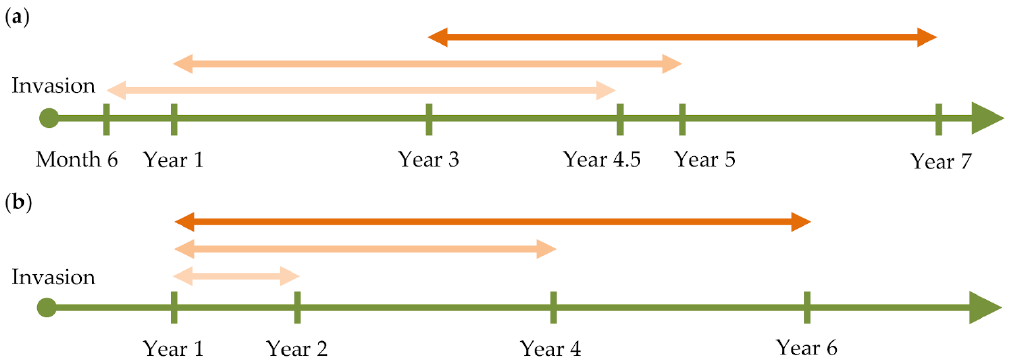
Figure 3. Diagrammatic representation of the two sets of simulations demonstrating use of the model. ( a ) Grass carp were stocked (1) six months, (2) one year, or (3) three years after invasion to determine the number that would be needed to eradicate Hydrilla within four years of stocking. ( b ) Grass carp were stocked one year after invasion to determine the number that would be needed to eradicate Hydrilla within (1) one, (2) three, or (3) five years after invasion.